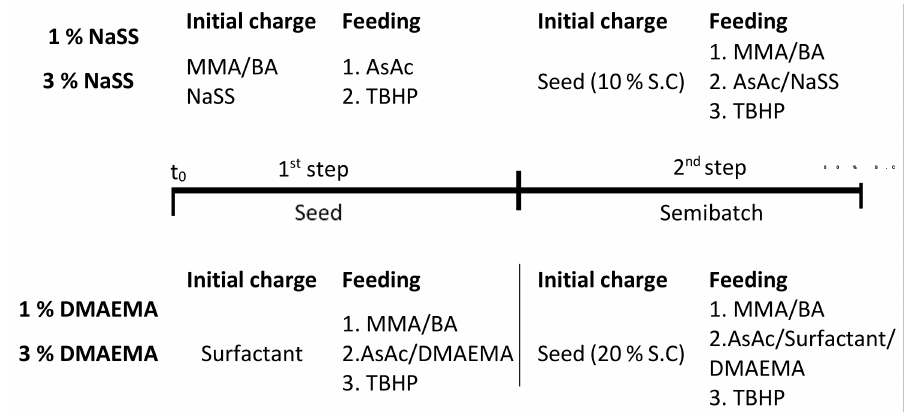
Scheme 1. Schematic representation of the synthesis process for anionically and cationically charged